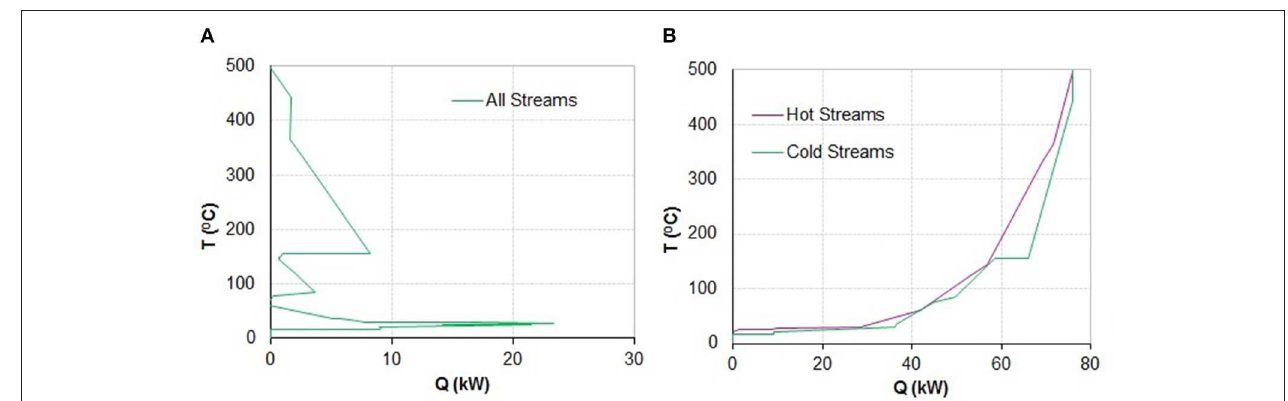
FIGURE 8 | Grand composite (A) and composite (B) curves for the CO 2 capture